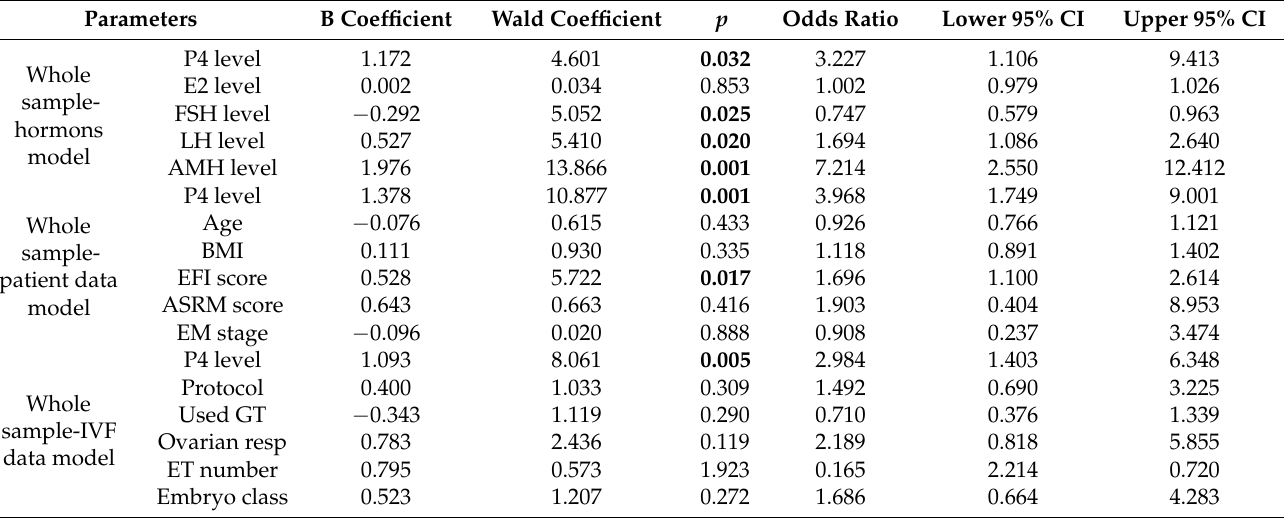
Table 4. Multivariable regression of the relationship between P4 levels and pregnancy achievement.